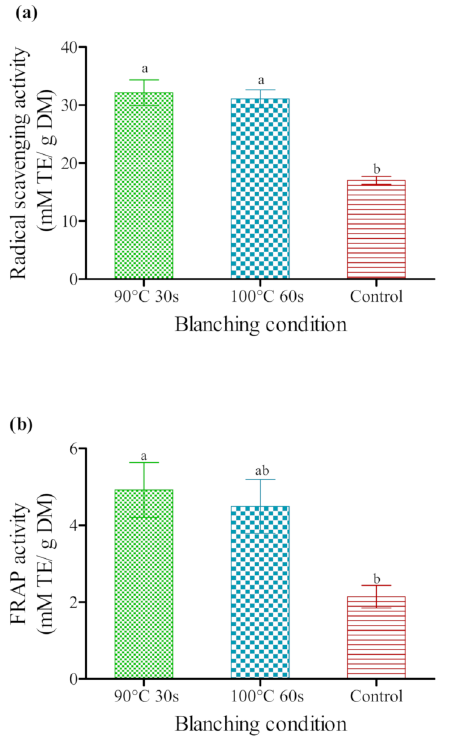
Figure 5. Antioxidant capacity ( a ) radical-scavenging activity (RSA) and ( b ) Ferric ion reducing antioxidant power (FRAP) activity of dried pomegranate arils cv. Wonderful at different blanching conditions. (Data presented as means ± SE. Bars followed by different letter(s) are significantly different ( p < 0.05) according to Fisher’s